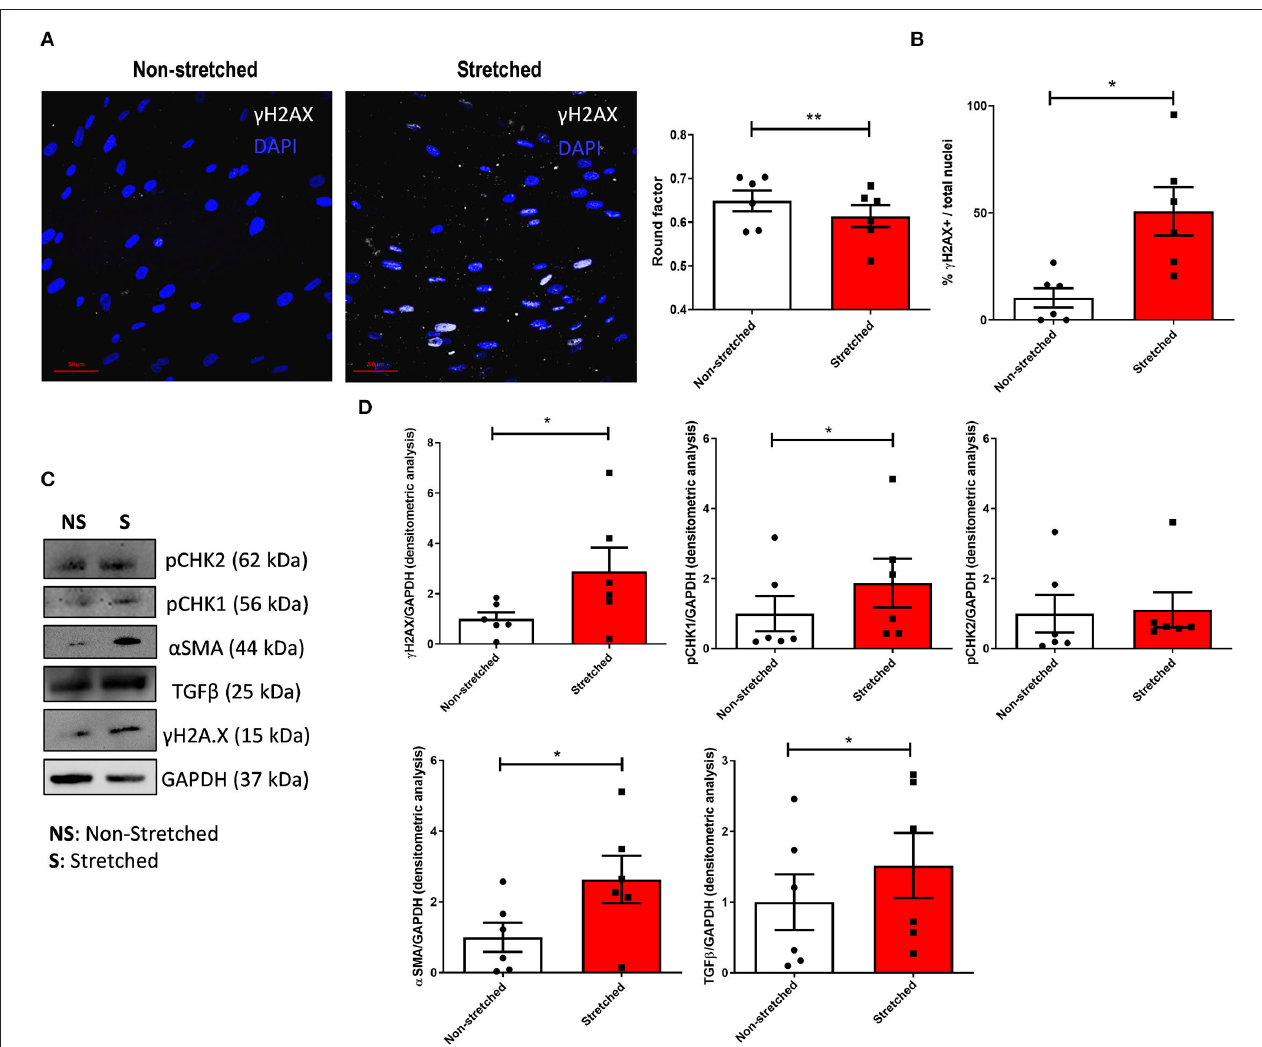
FIGURE 3 | Stretch-induced mechanical stress activates the DDR in HC C-MSCs. (A) Representative images of γ H2AX (white) immunostaining on non-stretched and stretched HC C-MSC and relative quantification. Nuclei are counterstained with Hoechst 33342 (blue). Scale bar represents 50 µ m. (B) Automated computer-based immunofluorescence image analysis. Left: nuclei roundness factor of cells culture in static vs. dynamic conditions; right: percentage of γ H2AX positive nuclei in the two culture conditions. * p < 0.05; ** p < 0.01. (C) Western blot analysis of γ H2AX, anti-pCHK1, pCHK2, TGF β , and α SMA in non-stretched and stretched HC C-MSC. Immunostaining of the housekeeping GAPDH is shown for normalization. (D) Densitometric analyses of γ H2AX, pCHK1, and pCHK2, TGF β and α SMA levels, normalized on GAPDH. * p <